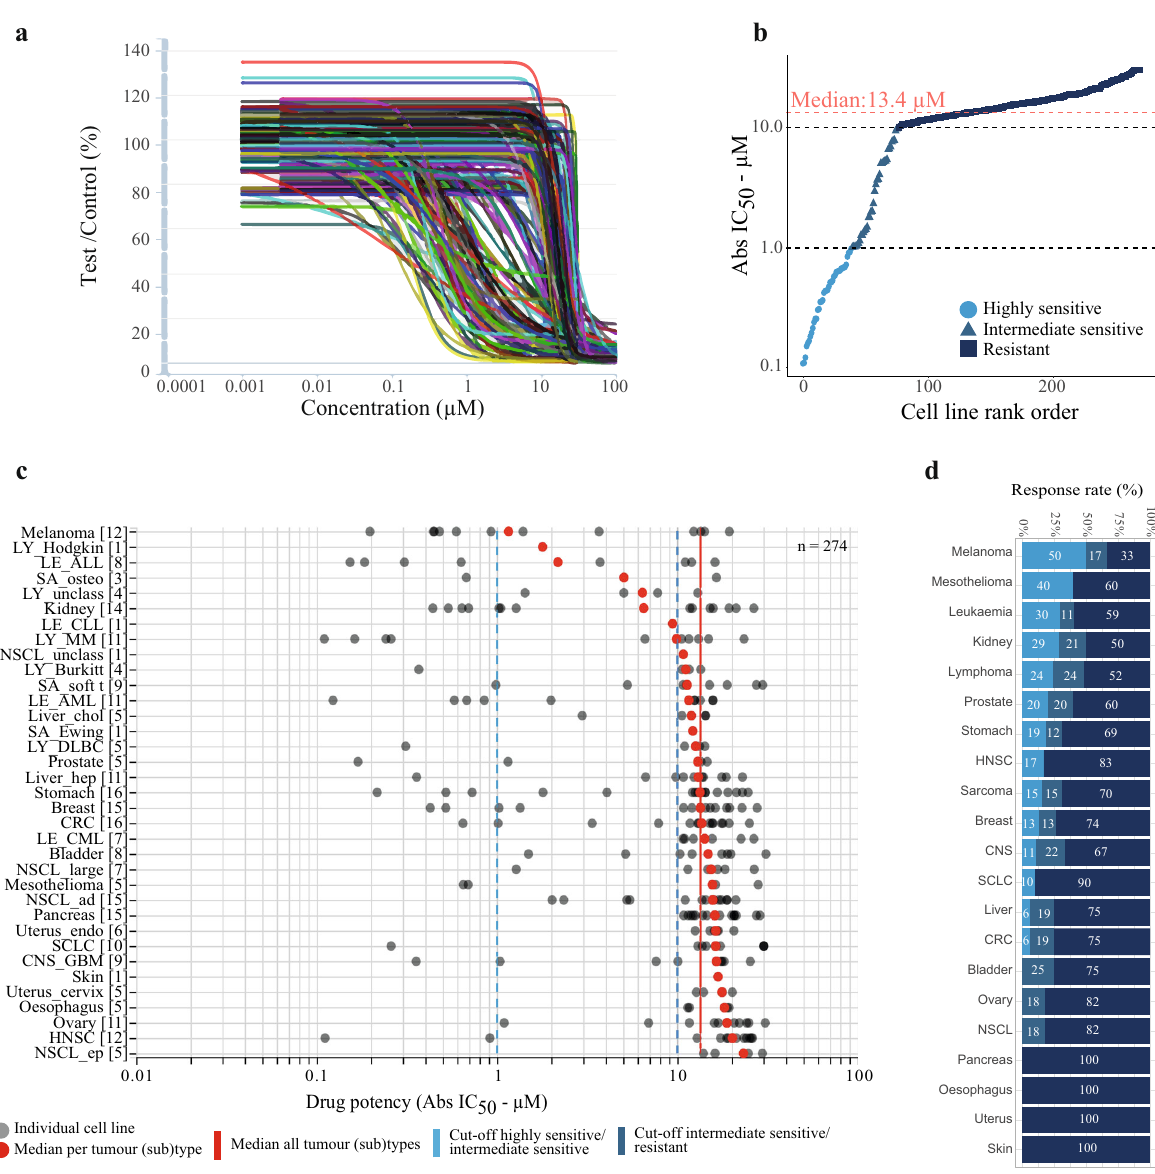
Fig. 1 The anti-tumour activity of MI-773 in the 274-CL panel in vitro. a The individual dose – response curves of all CLs to MI-773. Each line corresponds to a fi tted displacement curve for a CL. x -axis, MI-773 concentration in µM. Y -axis, drug effects on cell proliferation and survival expressed as Test/Control × 100 (%) values. b Rank ordered Abs IC 50 values obtained for each CL. The dashed red line depicts the median Abs IC 50 value. Dashed black lines are the cut-offs of 1 and 10 µM identifying highly sensitive (<1 µM), intermediate sensitive ([1, 10 [µM) and resistant ( ≥ 10 µM) CLs. c Scatter plot of the drug potency expressed with Abs IC 50 value per CL ( x -axis). On the y -axis, the histological (sub) types are sorted from top to bottom by increasing median Abs IC 50 values. Between brackets the total number of CLs within a tumour (sub) type. Abbreviations : CNS_GBM central nervous system: glioblastoma, CRC colorectal cancer, HNSC head &neck squamous cell, LE_ALL acute lymphoblastic leukaemia, LE_AML acute myeloid leukaemia, LE_CLL chronic lymphocytic leukaemia, LE_CML chronic myelogenous leukaemia, Liver_chol Liver_cholangioma, Liver_hep liver_hepatocellular, LY_Burkitt lymphoma_Burkitt, LY_DLBC lymphoma_Diffuse large B cells, LY_Hodgkin lymphoma_Hodgkin, LY_MM lymphoma_multiple myeloma, LY_unclass lymphoma_unclassi fi ed, NSCL_ad non-small cell lung_adenocarcinoma, NSCL_ep non-small cell lung_epidermoid, NSCL_large non-small cell lung_large cells, NSCL_unclass non-small cell lung_unclassi fi ed, SA_Ewing Sarcoma Ewing, SA_osteo osteosarcoma, SA_soft t sarcoma soft tissue, SCLC small cell lung, uterus_endo uterus_endometrium. d The percentage of highly sensitive (light blue), intermediate sensitive (grey-blue) and resistant CLs (dark blue) to MI- 773 across different tumour